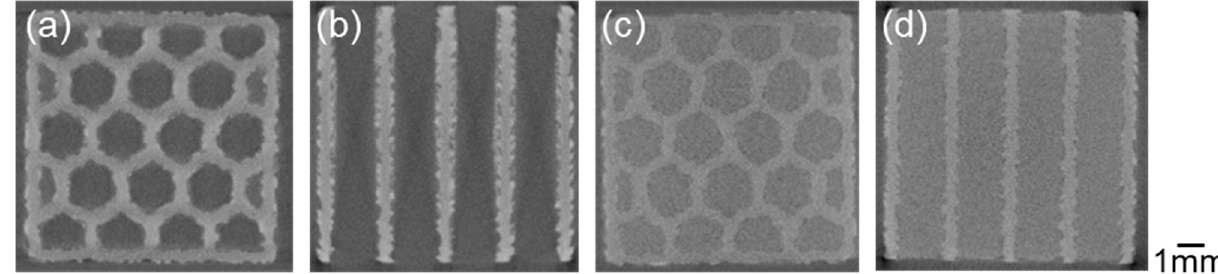
Figure 2. µ -CT cross-section images for ( a , b ) porous specimen with elongated honeycomb pores and ( c , d ) powder/solid composite specimen with residual unmelted powder particles inside the pores.